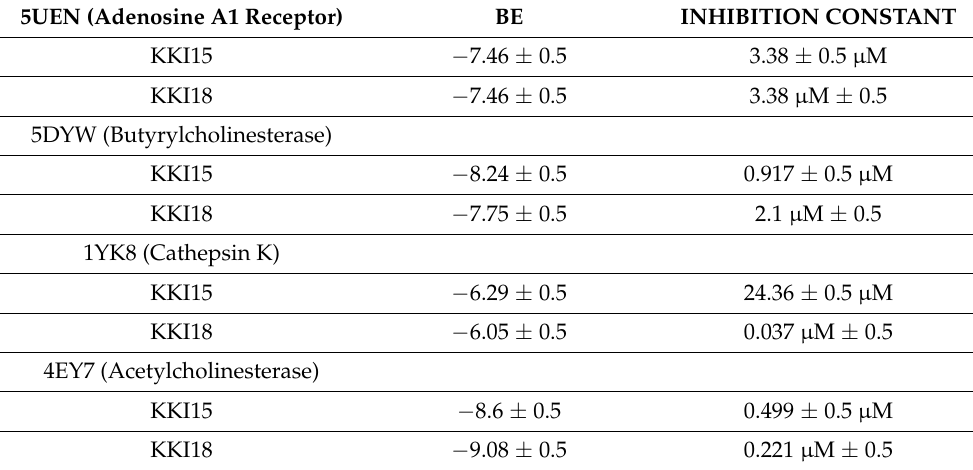
Table 6. Binding energies BE (kcal/mol) and Inhibition constants between the compounds and macromolecules. 5UEN (Adenosine A1